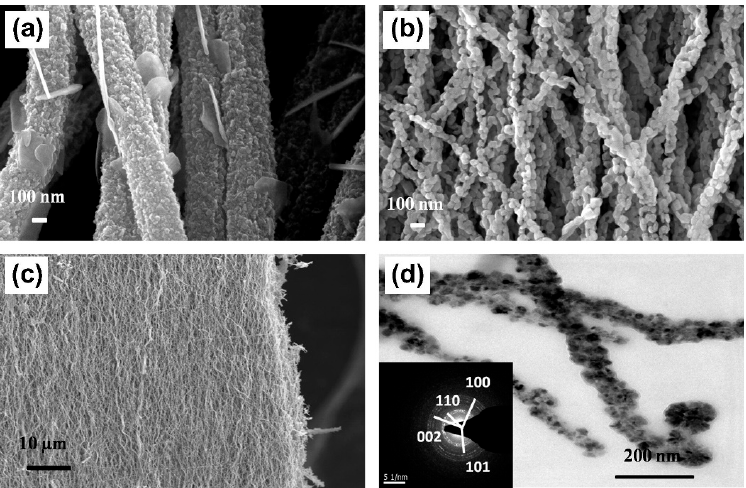
Figure 7. FEEM micrographs of ZnO nanofibers fabricated by calcining at different temperatures: ( a ) 450 °C; ( b ) 650 °C; ( c ) ZnO nanofibers collected in the form of a free standing mat calcined; and ( d ) a TEM micrograph of ZnO nanofibers and the selected area electron diffraction patterns (SAED) (inset). The arrows indicate different crystal planes of ZnO. Reprinted from [14]. Copyright (2013), with permission from Elsevier.